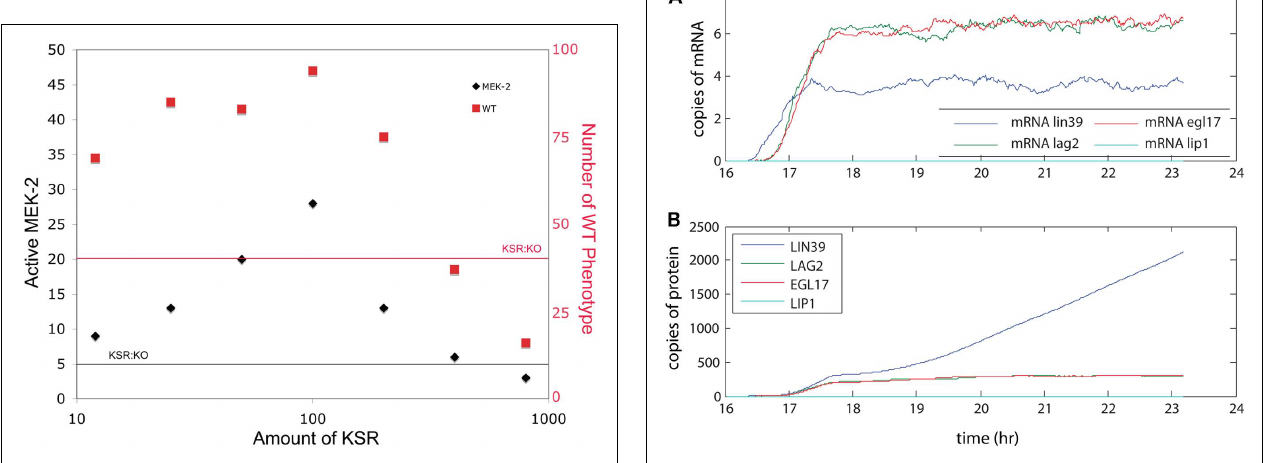
FIGURE 3 |The effect of varying scaffold concentration on downstream signal strength. The number of scaffold proteins is varied and the mean number of active MEK-2 species across 100 simulations is determined.The number of organisms developing asWT is also plotted.The horizontal lines show levels for the KSR knockout for comparison.